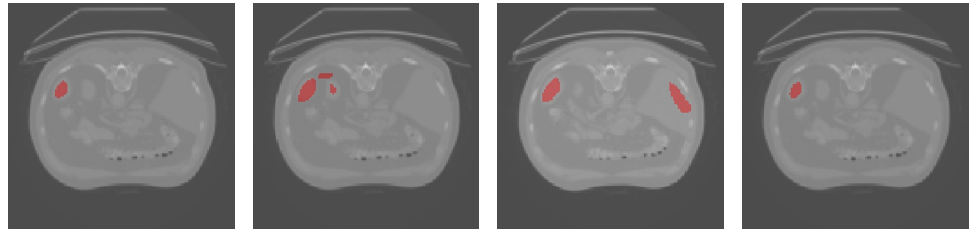
Figure 4. Qualitative results obtained for the spleen CT images. From left to right: ground truth, U-Net, Att-UNet, and SAB-Net.